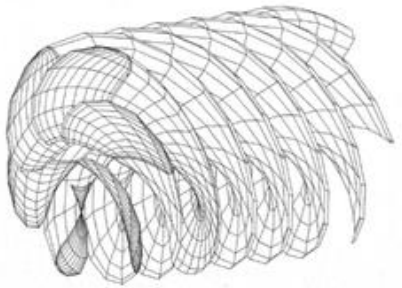
Figure 8. Vortex structure in the propeller wake in QCM for a typical propeller in a homogeneous inflow.